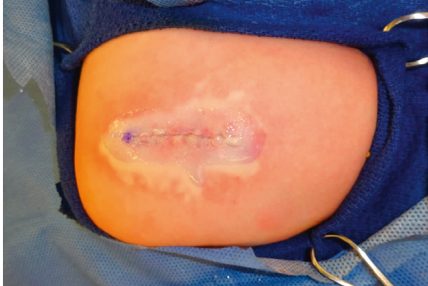
Figure 2: Excision of mass and primary closure.